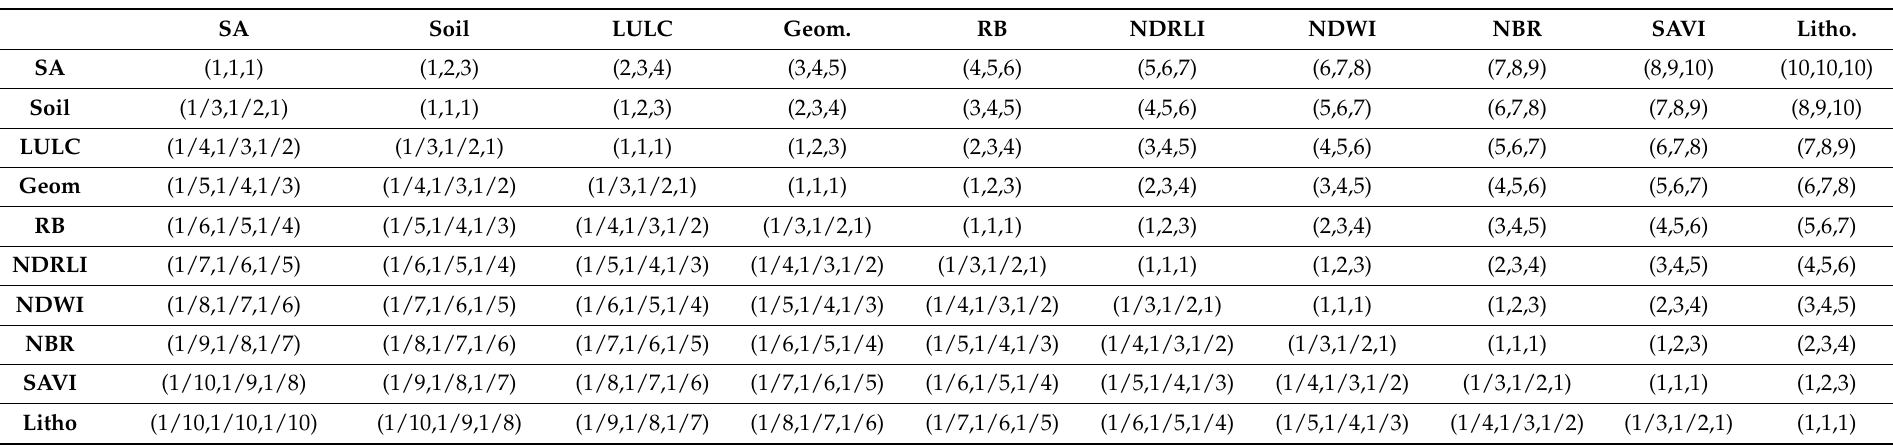
Table 4. Pair-wise comparisons of